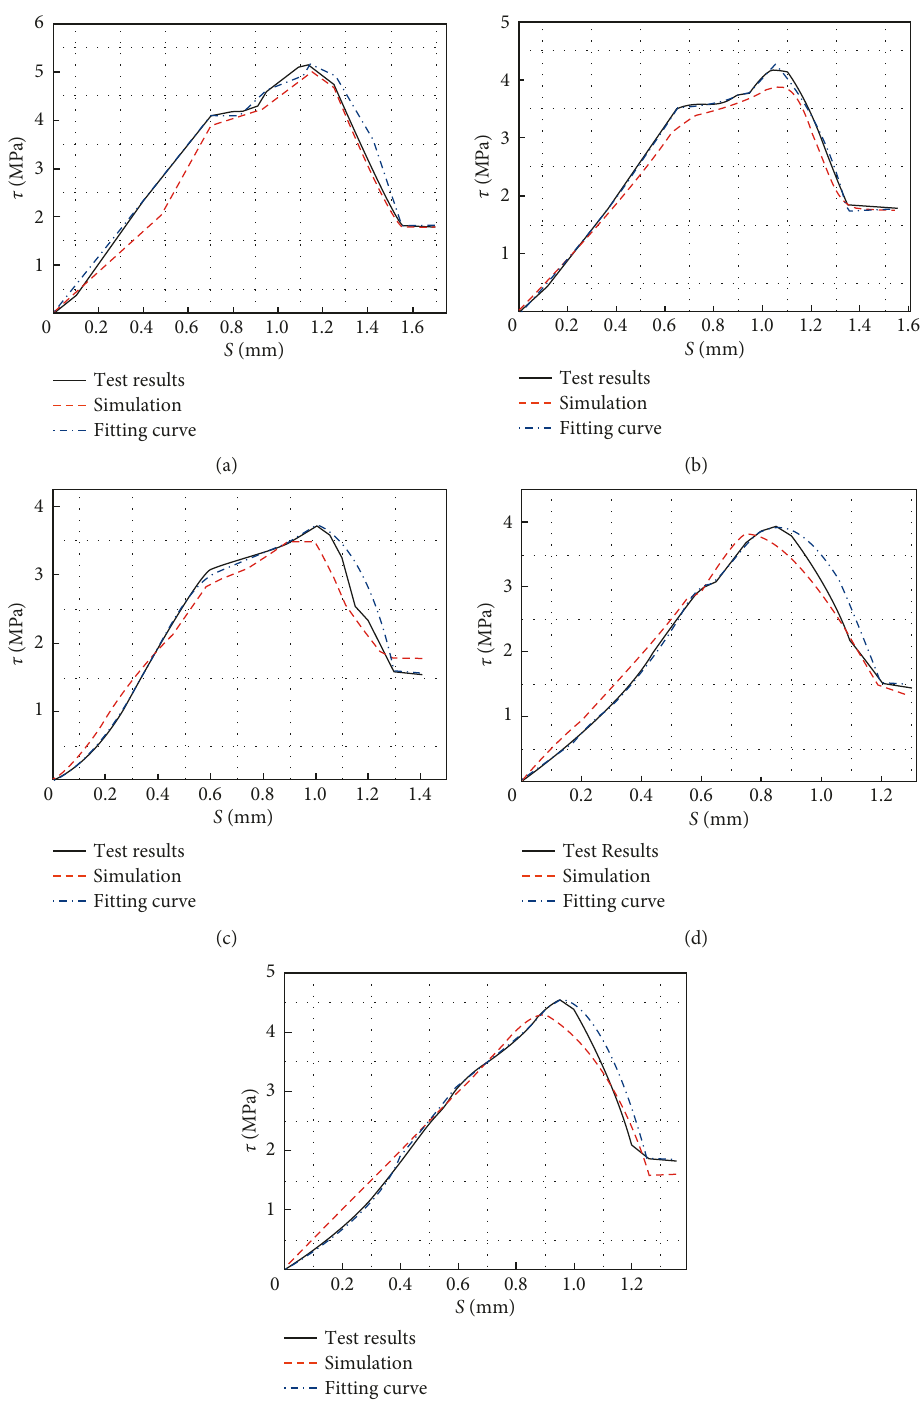
Figure 14: Comparison of test results, fitting curve, and simulation results. (a) D90-L90. (b) D90-L135. (c) D90-L180. (d) D80-L120. (e)